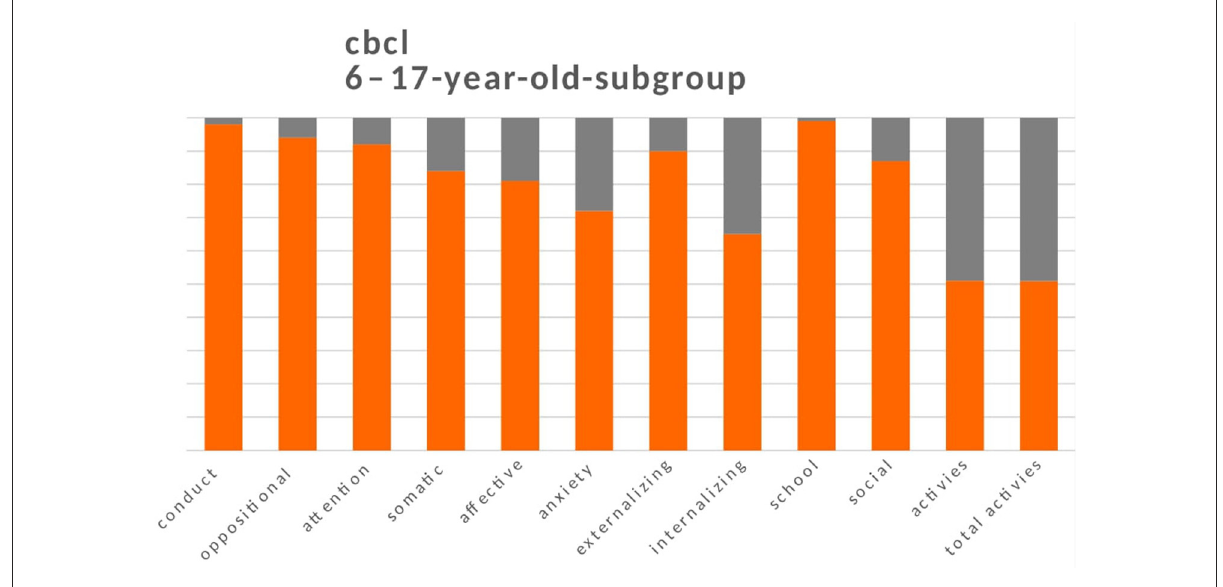
FIGURE3 Child Behavior Checklist (CBCL) for the 6-17-year-old subgroup.